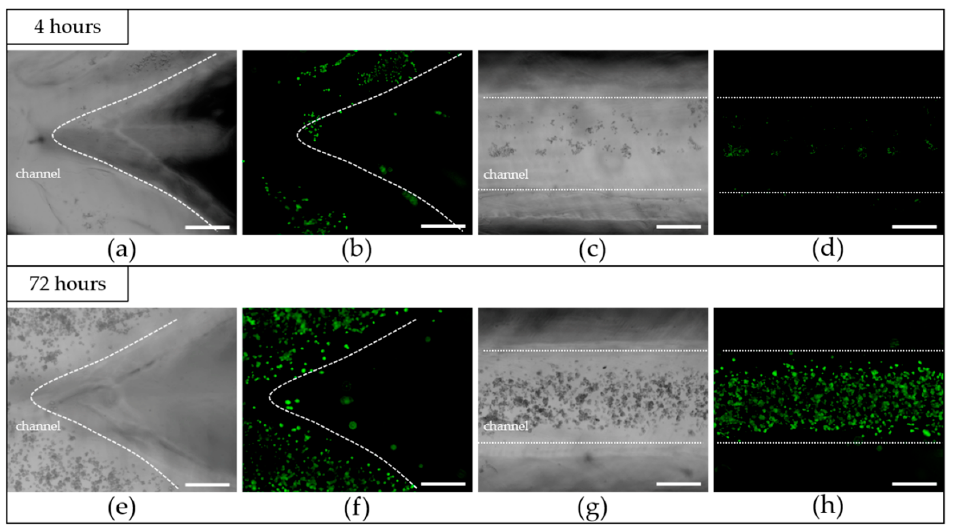
Figure 9. Microscopic images and fluorescent images of cells; the dotted lines were used to divide the inside and outside of the channel: ( a , b ) after 4 h of attachment at the bifurcate area of the TEVG, ( c , d ) after 4 h of attachment at the linear channel of the TEVG, ( e , f ) after 72 h of culturing at the bifurcate area of the TEVG, ( g , h ) after 72 h of culturing at the linear channel of the TEVG. (Scale bars: 500 μ m).